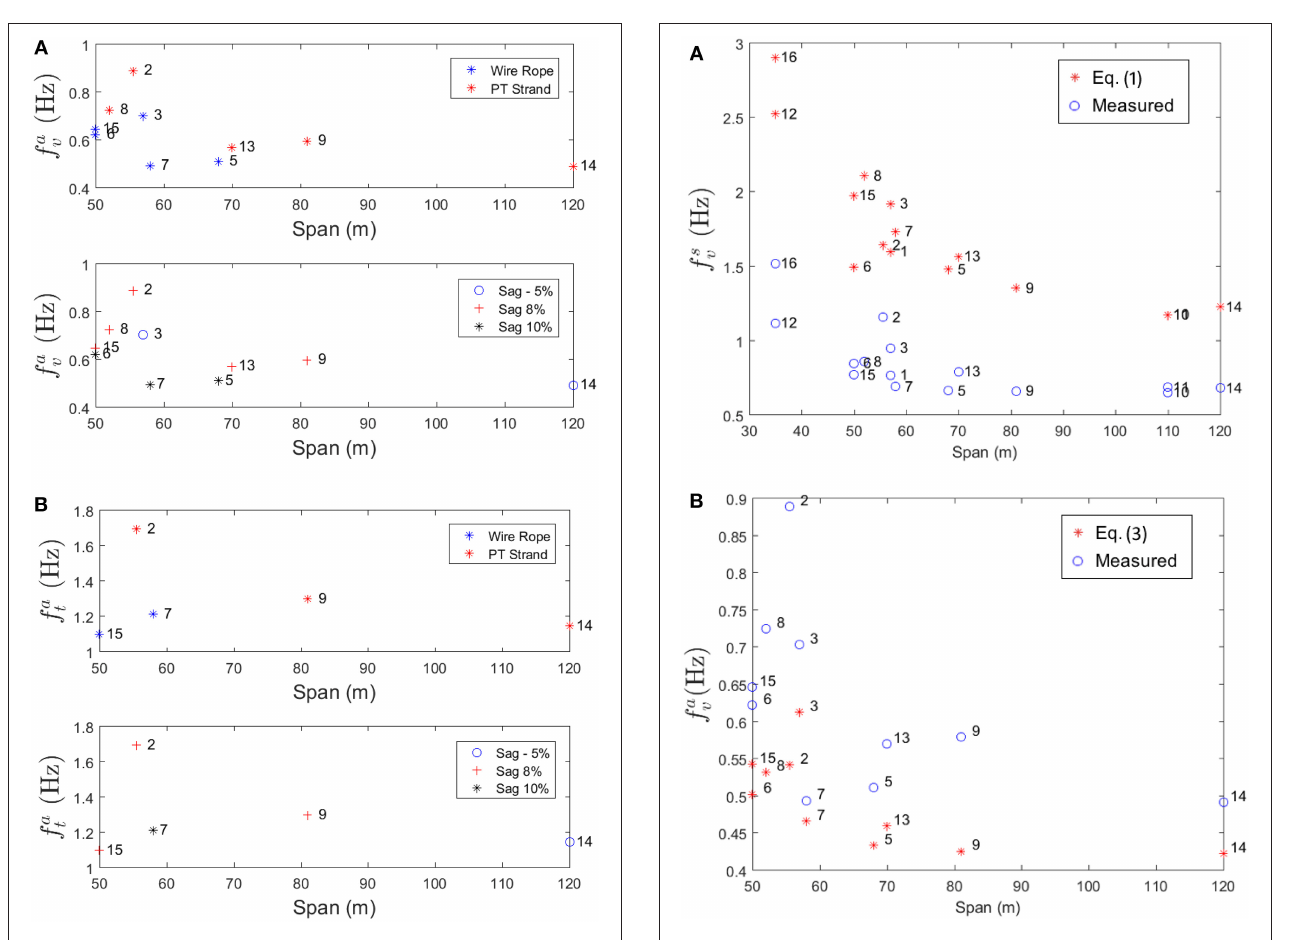
FIGURE 10 | Vertical (A) and torsional (B) anti-symmetric frequencies of footbridges.